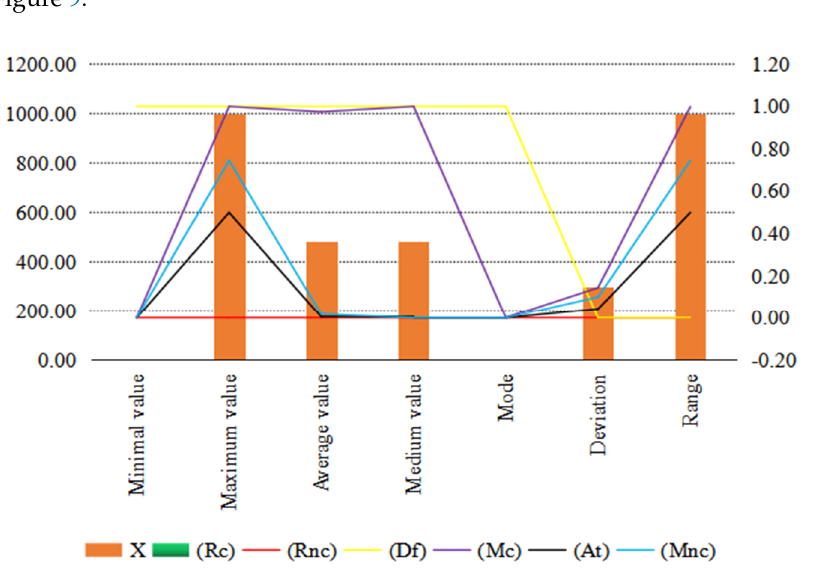
Figure 10. All rational nodes choosing defender strategies and Rc ≠ 0. In Figure 10, to determine the simulation results, wide area wireless sensor networks appeared, the range increased up to 10,000, and the rational nodes strategy was nonzero. In the system, after allowing a period of time for evolution to elapse, the malicious node chose the cooperative strategy to maximize its interests because the rational node chose defensive measures. Thus, the malicious node can multiply inorganically, and the malicious node will always choose the cooperative strategy.